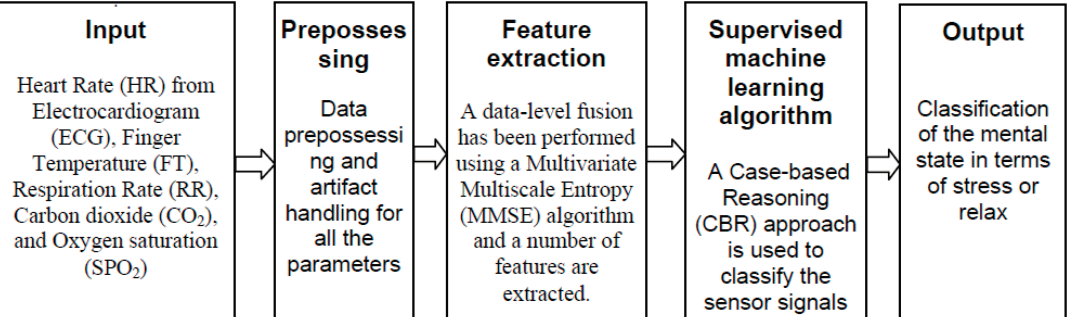
Figure 4. An overview of the classification scheme to identify mental state in terms of Stressed or Relaxed considering the data-level